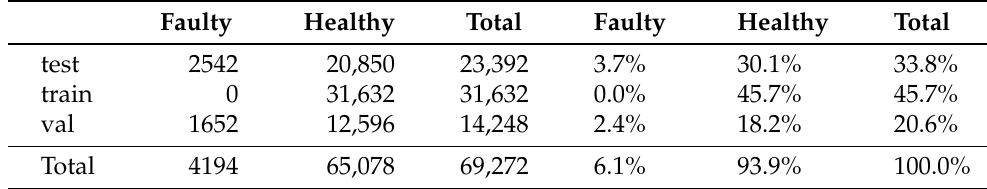
Table 4. Cooling unit dataset.